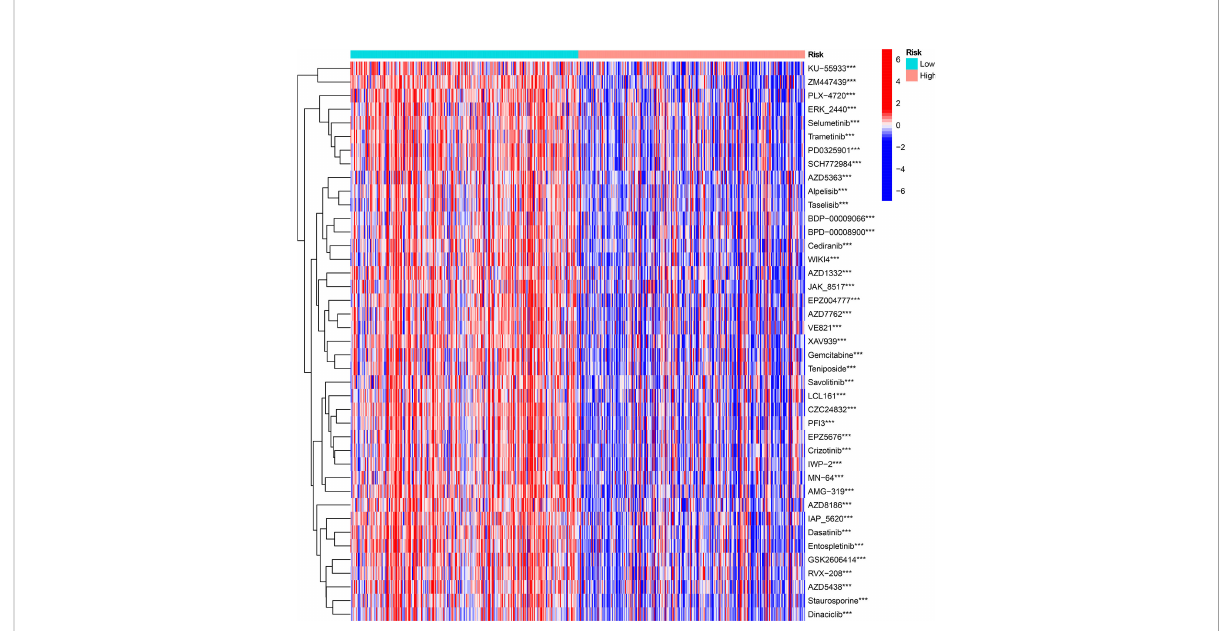
FIGURE 12 The drug sensitivity prediction and comparison of ICD-high and ICD-low risk groups from the GDSC database are sum up in a heatmap. *** P <